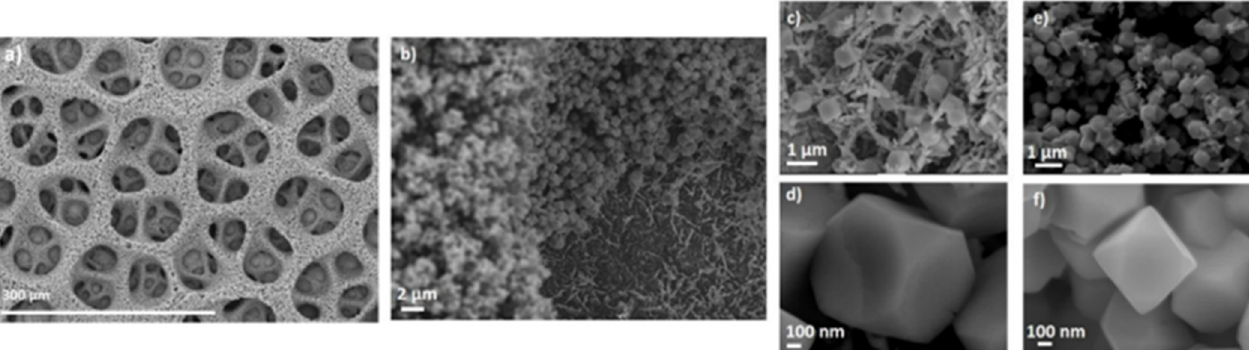
Figure 4. SEM of CF-18H-DCU. ( a ) Overview, ( b ) view down a pore, ( c , d ) ×15,000 and ×70,000 magnifications, respectively, of the surface of the foam, focusing on the cuboctahedra and ( e , f ) ×15,000 and ×70,000 magnifications, respectively, of the bottom of the foam, focusing on the cuboctahedra.